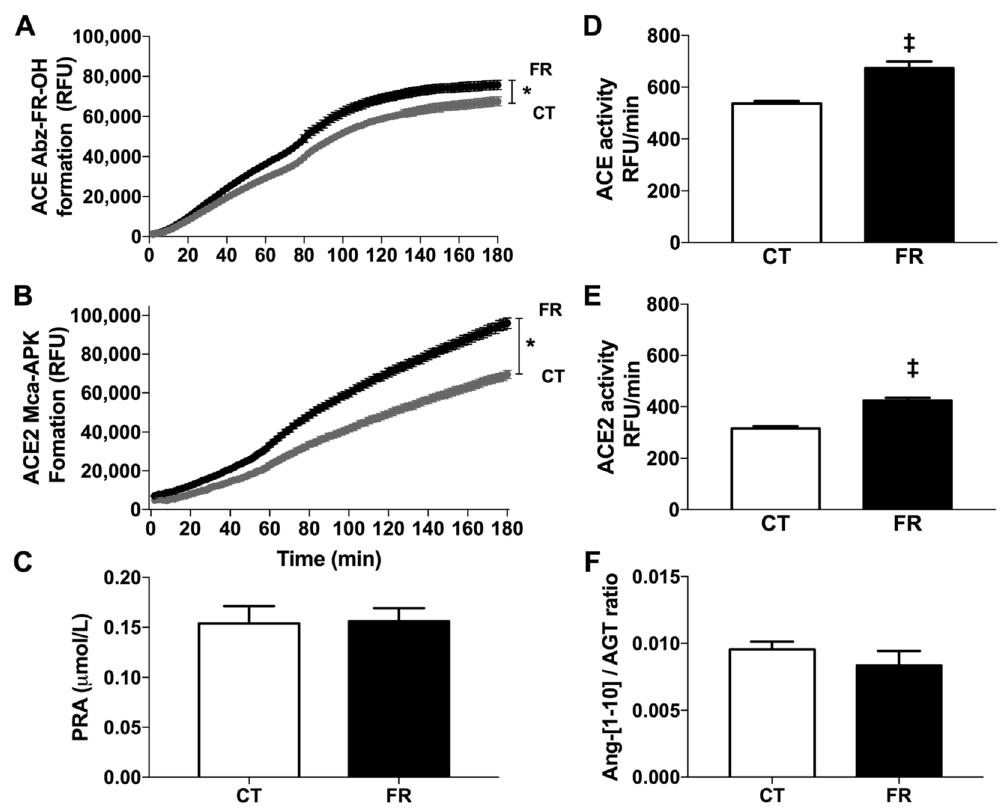
Figure 5. Effect of FR on plasma ACE, ACE2 and renin activity. Shown is the time course of product formation ( A , B ) and enzyme activity ( C , D , E ) for ACE (n = 8/group) ( A , D ), ACE2 (CT, n = 8; FR = 9) ( B , E ) and renin (CT, n = 8; FR, n = 10) (C) in the plasma and the ratio of Ang-[1–10] over AGT production (CT, n = 10; FR, n = 11) ( F ) in CT (grey circle; white bar) and FR (closed circle; black bar) female rats. * P < 0.001 vs. CT by two-way ANOVA and Bonferroni post-hoc test (time; diet); ‡ P < 0.0001 vs. CT, same treatment, by unpaired Student’s t - test. Values are expressed as the mean ± SEM.